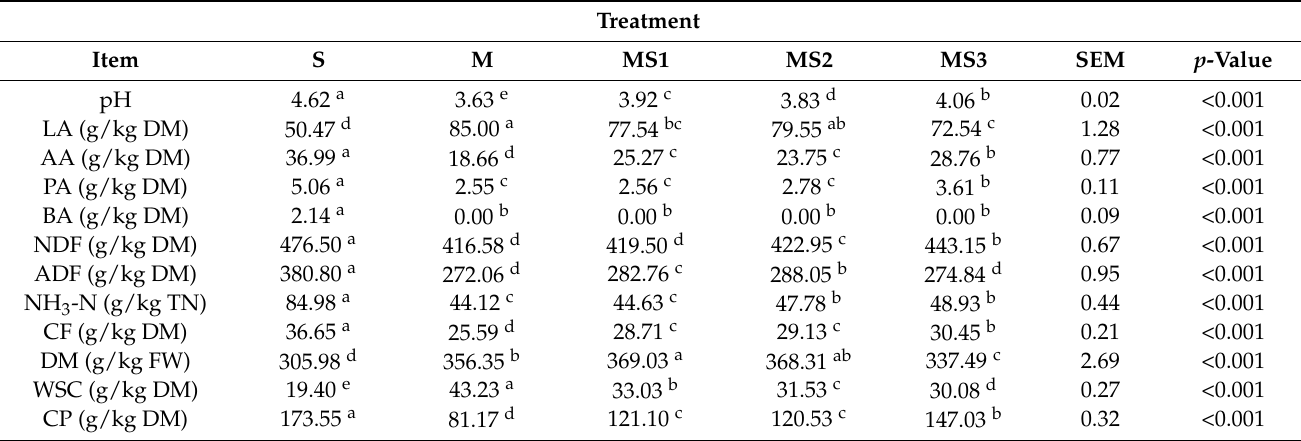
Table 3. The fermentation quality and chemical composition of different mixed silage treatments after